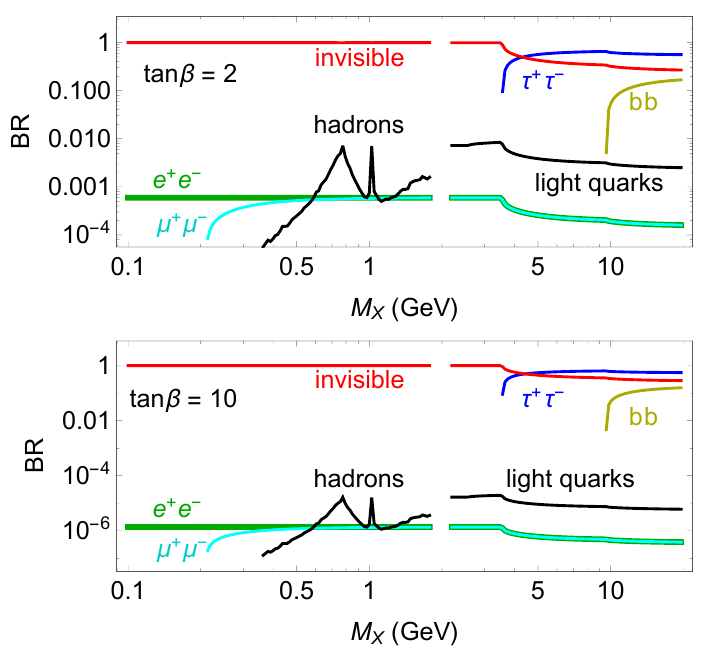
Figure 1. Branching ratios of X for two values of tan (cid:12) (cid:17) v 2 =v 1 with no kinetic mixing.